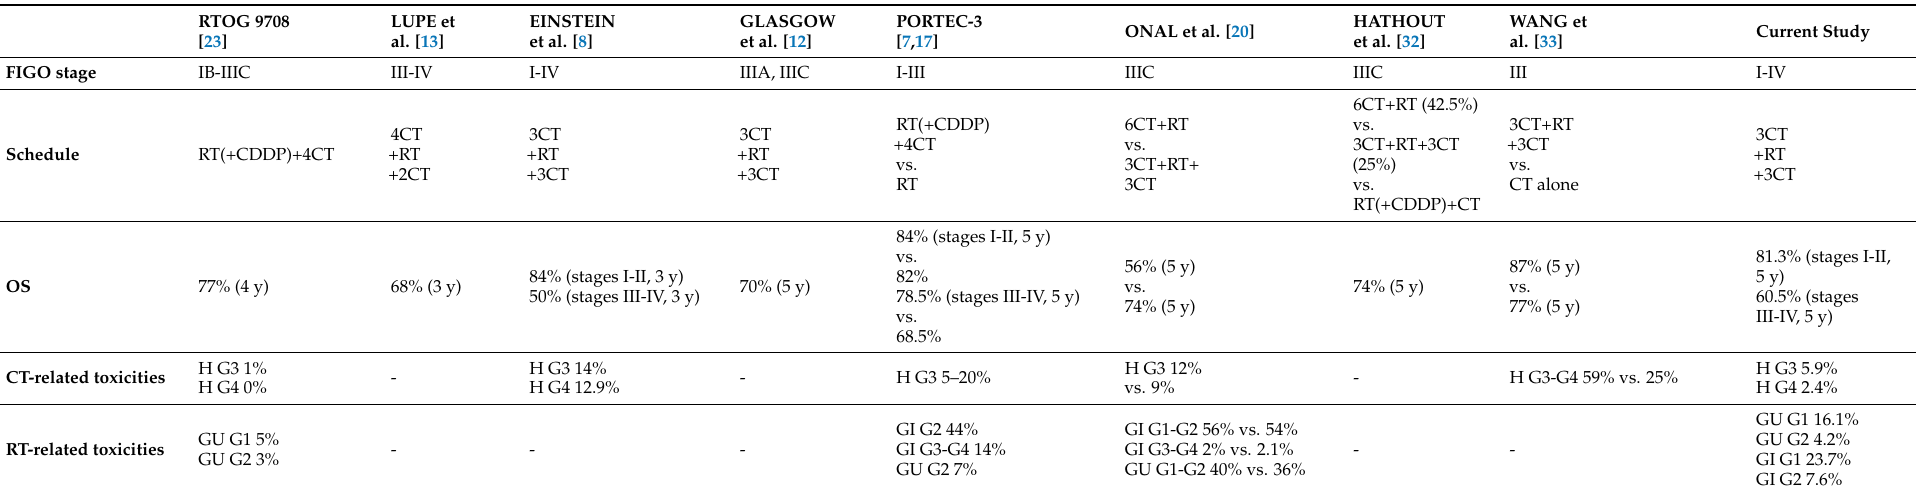
Table 4. Summary of available